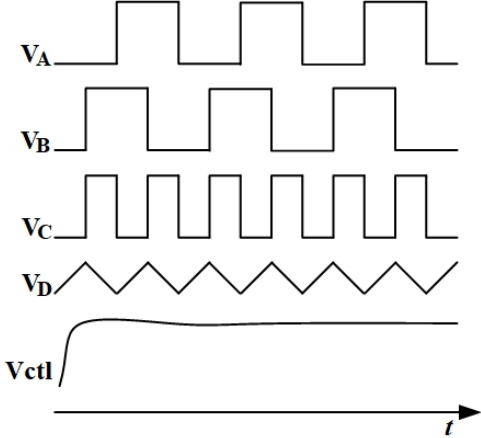
Figure 7. Simplified operation waveforms of the signal observation.